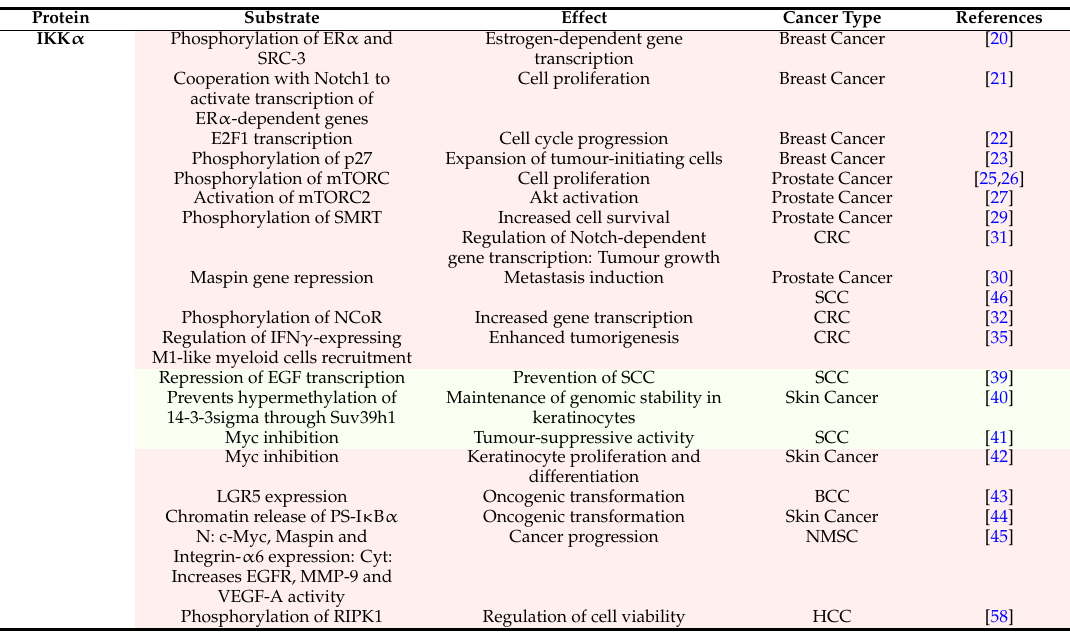
Table 1. Table summarizing the published data on non-conventional functions of the NF- κ B members in cancer. The red background shows pro-tumorigenic functions and the green background shows anti-tumorigenic activities. Abbreviations: ER α : estrogen receptor α ; SRC-3: nuclear receptor coactivator-3; mTORC: mammalian target of rapamycin complex; SMRT: silencing mediator for retinoid and thyroid receptors; N-CoR: nuclear correpresor; IFN γ : interferon γ ; EGF: epidermal growth factor; LGR5: leucine-rich repeat-containing G-protein coupled receptor 5; PS-I κ B α : phospho-sumo inhibitor of κ B α ; EGFR: epidermal growth factor receptor; MMP-9: matric metallopeptidase 9; VEGF-A: vascular endothelial growth factor-A; RIPK1: receptor interacting serine/threonine kinase 1; FOXO3a: forkhead box O3; MKK4/7: mitogen-activated protein kinase kinases 4 and 7; JNK: c-Jun N-terminal kinase; HDAC: histone deacetylase; PRC2: polycomb Repressive Complex 2: NEMO: NF κ B essential modulator; NF κ B: nuclear factor κ B; Casp8: caspase 8; HIF α : hypoxia-inducible factor α ; CBP: CREB-binding protein; CRC: colorectal cancer; SCC: squamous cell carcinoma; BCC: basal cell carcinoma; NMSC: non-melanoma skin cancer; HCC: hepatocellular carcinoma; ccRCC: clear cell renal cell